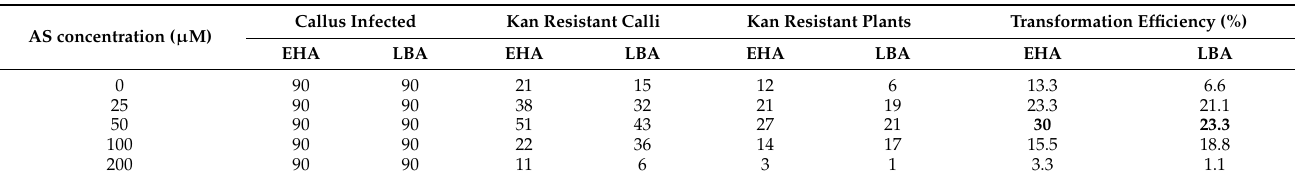
Table A5. Effect of AS concentration in co-cultivation medium on transformation efficiency of callus derived from seeds of P. scrobiculatum